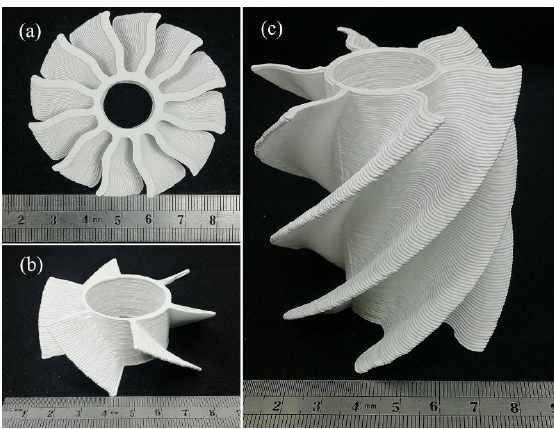
Fig. 7 Printed impeller samples of the Al 2 O 3 green body.